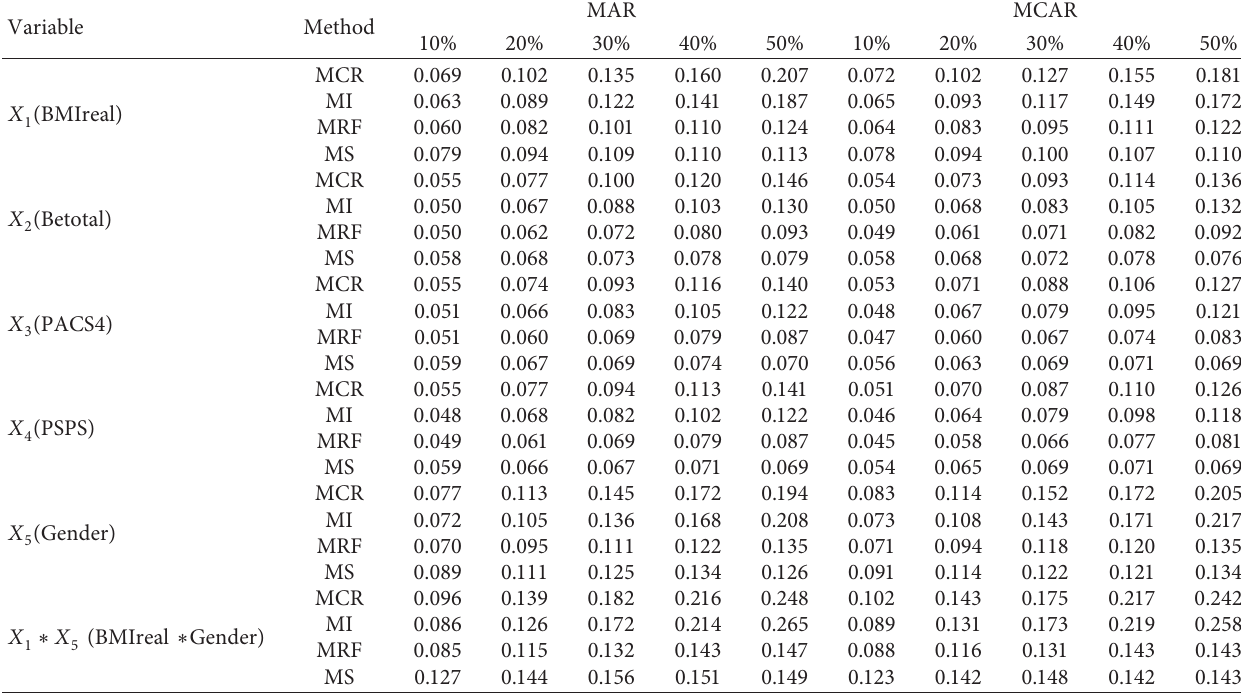
Table 5: Comparison of the performance of imputation methods based on the empirical SE of regression coefficients over 1000 simulations.